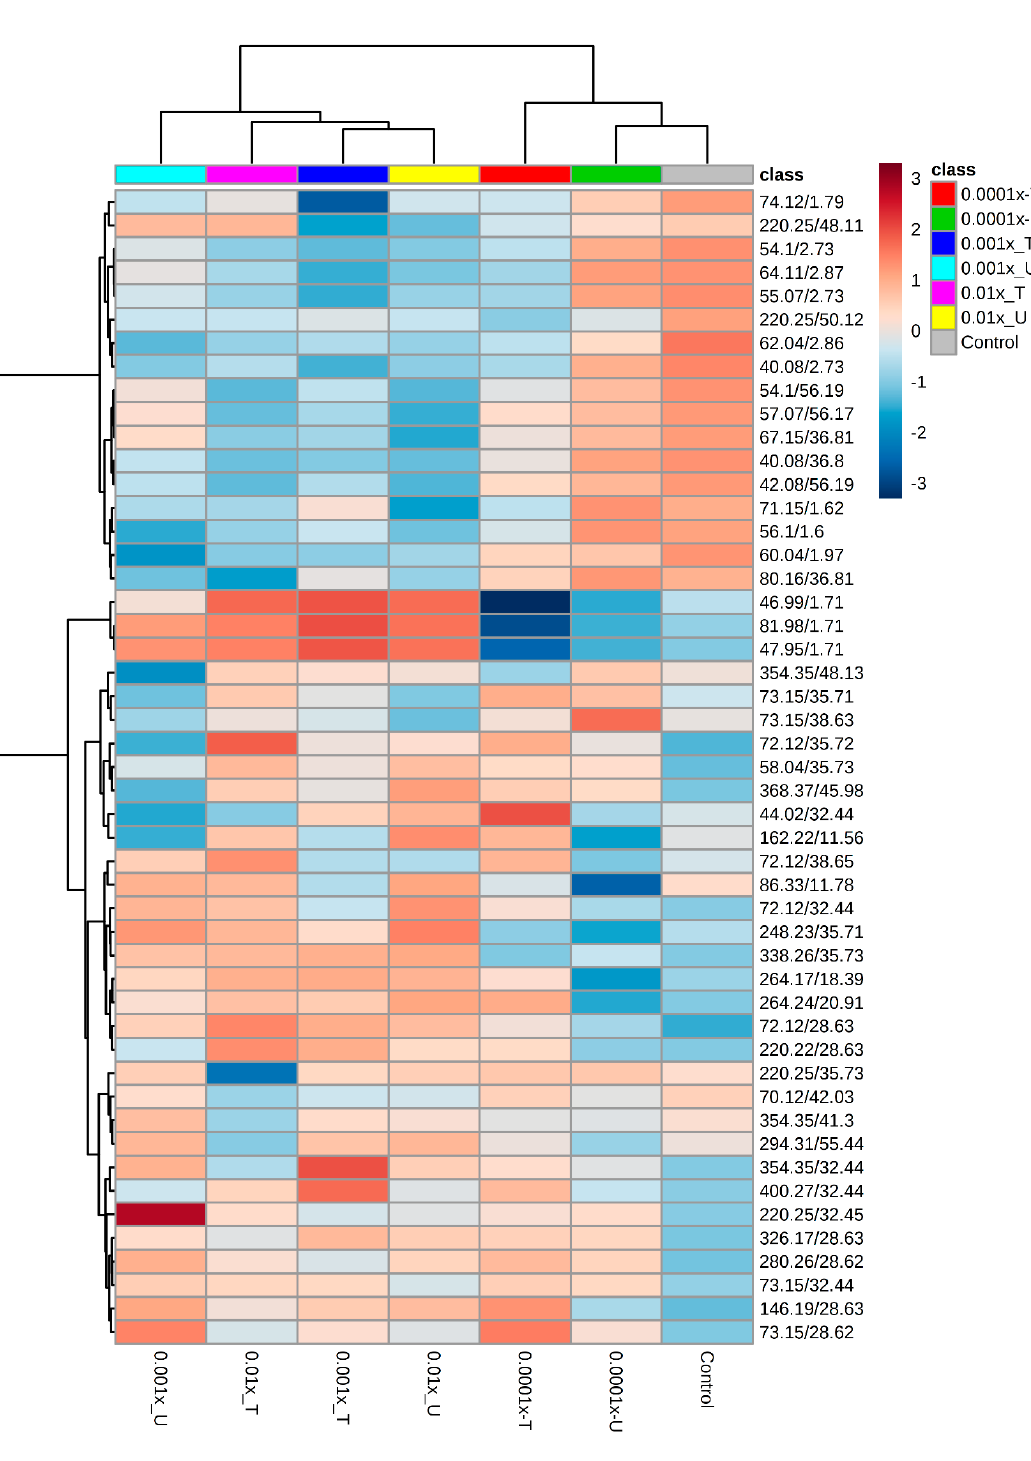
Figure 4. Metabolic fingerprint of susceptible Avena fatua L. plants that have been treated previously (T = Treated) and plants that received their first application (U = Untreated) of clodinafop propargyl at rates of 0.01, 0.001, and 0.0001x of the recommended dose. The heatmap was constructed with the 46 metabolites that showed p - and q - values ≤ 0.05. Colors represent the abundance of metabolites; the blue color indicates down-expression and red color over-expression. The metabolites are clustered according to their Pearson correlation as a distance function, and the Ward clustering algorithm, the significance of the branches were p ≤